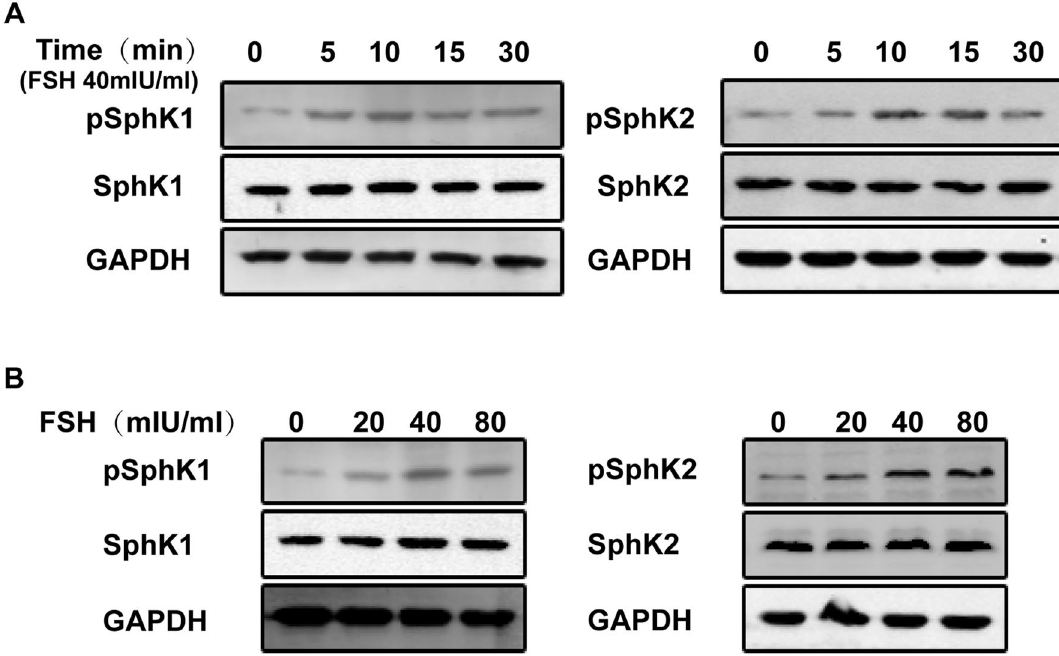
Figure 3. Stimulation of FSH activated phosphorylation of SphK, and raised its activity of SphK in EOC cells. ( A ) FSH stimulated serum starved HO8910 cells for the indicated time. Immunoblotting analysis with specific anti-phosphorylated SphK1 (pSphK1) and pSphK2 antibodies was performed to detect the activity of SphK1 and SphK2. The histogram showed the densitometric analysis of pSphK1 and pSphK2 (normalized to SphK1 and SphK2). ( B ) Serum-starved HO8910 cells were treated with FSH at indicated doses. After 15 min stimulation, pSphK1 and pSphK2 were determined by immunoblotting analysis. Data are mean ± SD. * P < 0.05, vs.